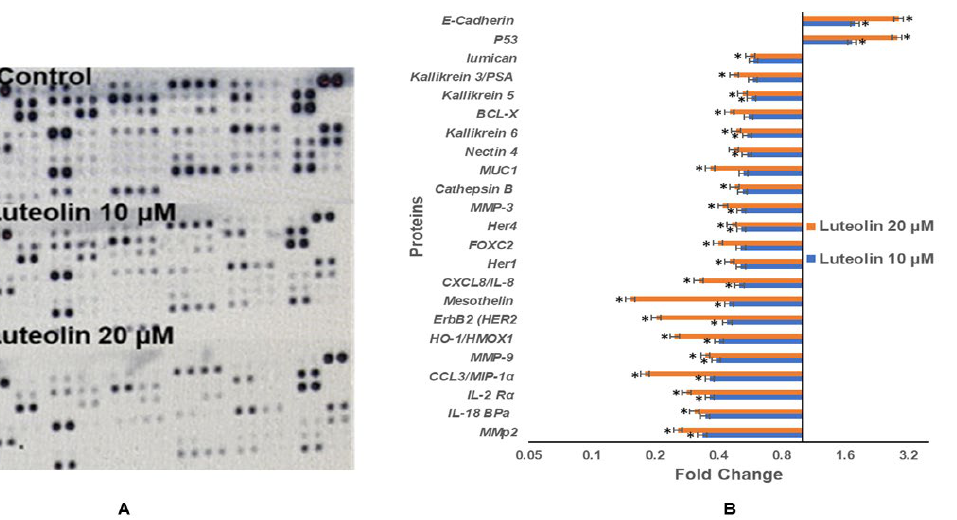
Figure 4. Luteolin treatment modulates the proteins related to migration and inflammation in a dose-dependent manner. ( A ). The blots show expression of different proteins. ( B ). Fold change in different proteins related to migration and inflammation (* represents that data is statistically significant with p ≤ 0.05).